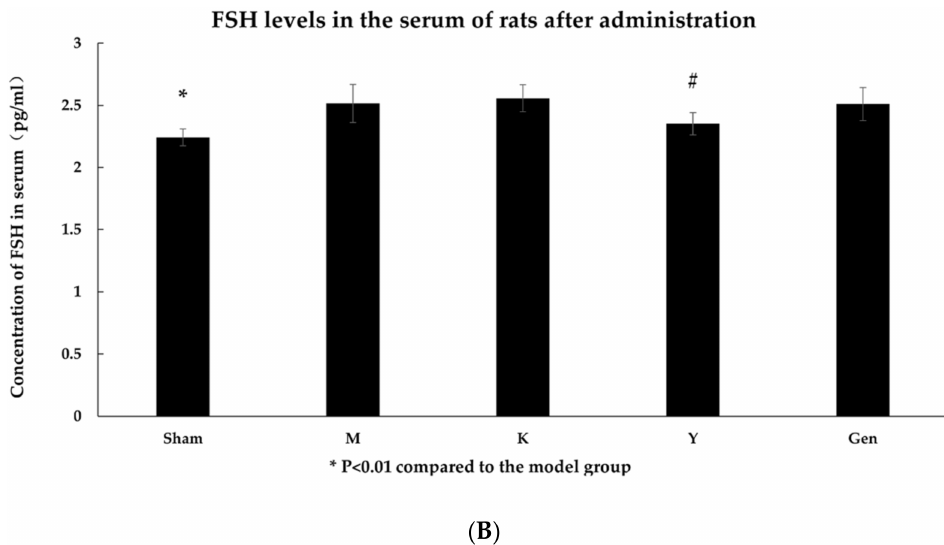
Figure 6. ( A ) The concentration of E2 in the serum of rats after administration was significantly higher in Sham and Y groups than in M group. ( B ) The concentration of FSH in the serum of rats after administration was significantly lower in the Sham and Y groups than in the M group. * p < 0.01 compared to the model group. # p < 0.05 compared to the model group.